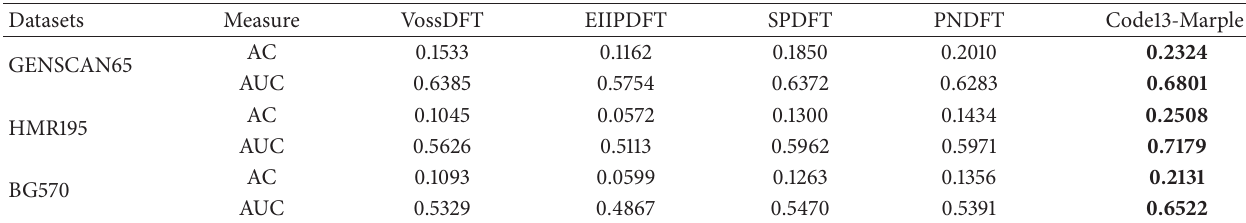
Figure 8: The distribution of exonic regions lengths in HRM195. The horizonal axis represents the exonic regions length, and the vertical axis represents the number of exonic regions. Table 2: Performance measures of five mapping methods for three benchmark